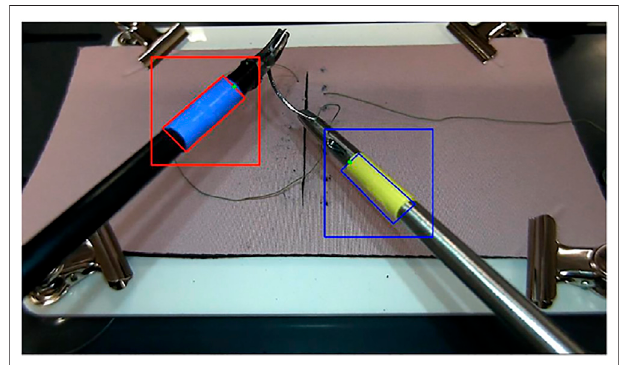
FIGURE 3 | Sample ROI squares around the markers.